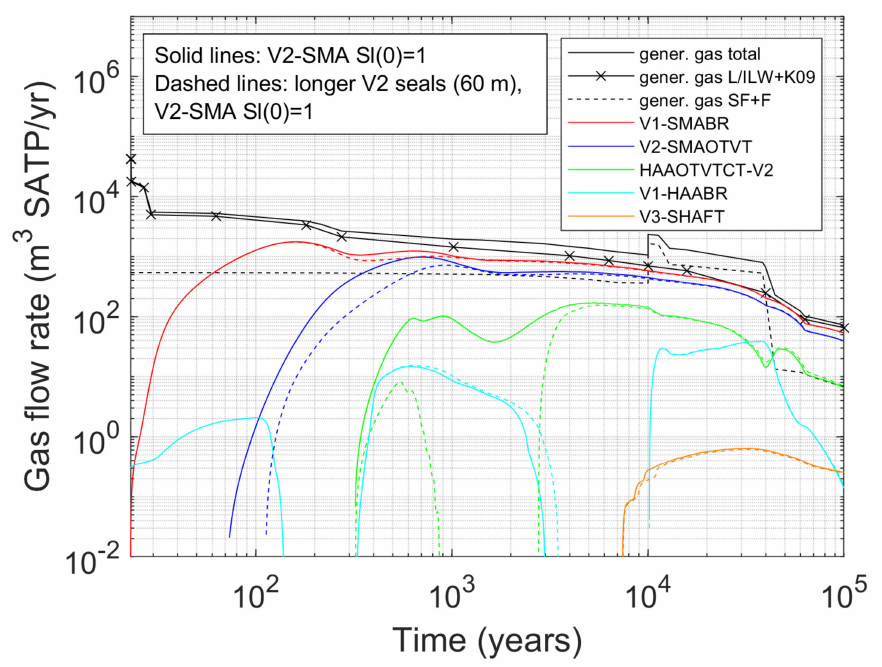
Figure 13. Gas flow rates through selected sections of the repository (red: V1 seals to branch tunnels, blue: V2 seals to operation tunnels, orange: V3 seals to shaft) for two configurations of the V2-L/ILW seal.